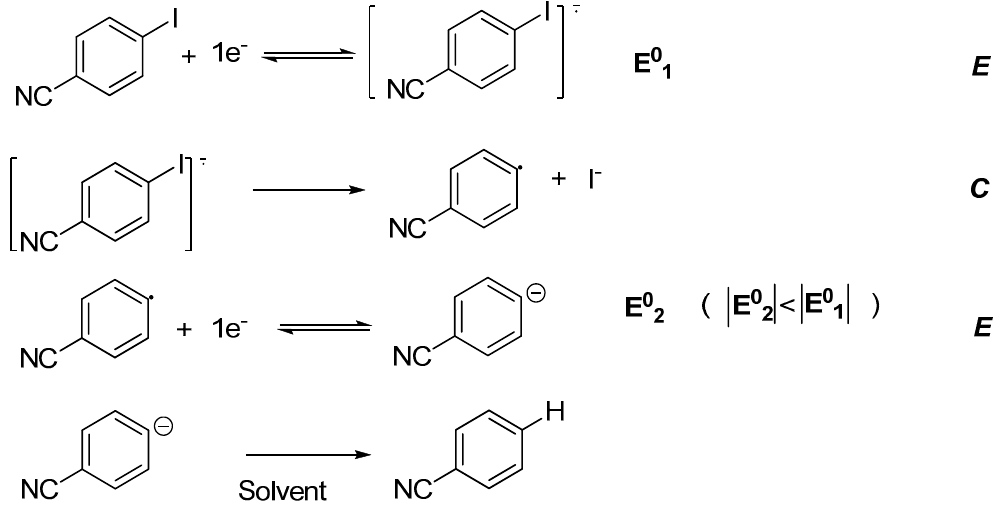
Figure 3. Experimental conditions and the cyclic voltammogram of a 5 mL solution of 1 (10 mM) before (black line) and after (blue line) controlled potential electrolysis under an inert